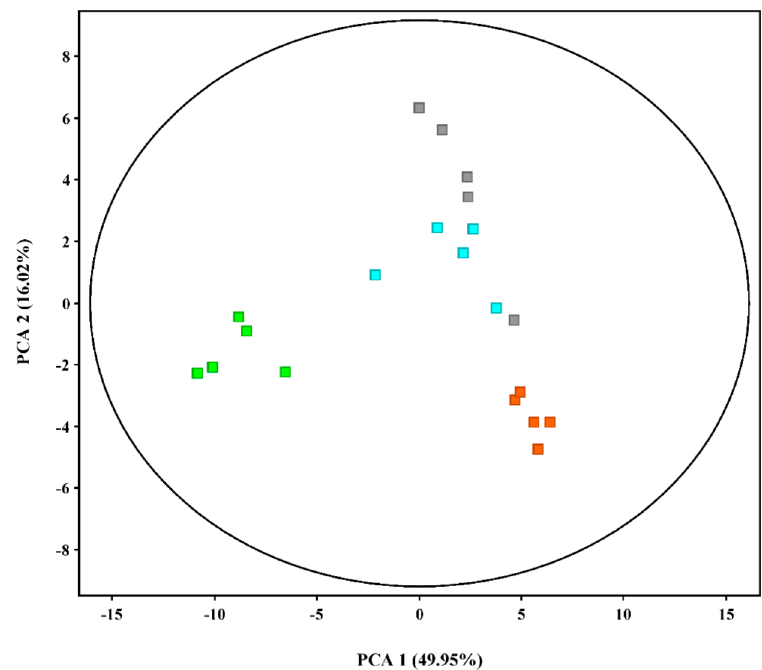
Figure 3. Principle component analysis (PCA) scores of metabolomes in rice seedlings inoculated with Magnaporthe grisea without chemical treatment (A group, (cid:4) ) or treated with probenazole at 75.00 g · m − 2 (B group, (cid:4) ), 112.50 g · m − 2 (C group, (cid:4) ), and 150.00 g · m − 2 (D group, (cid:4)